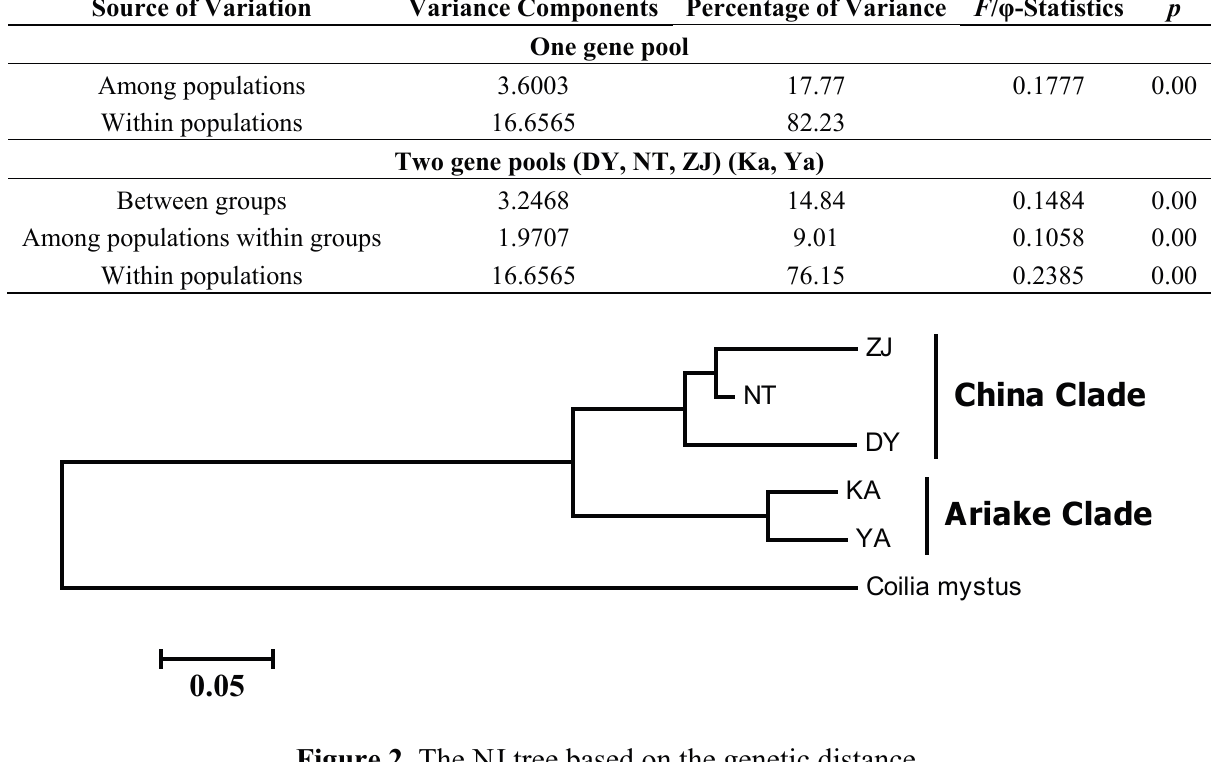
Figure 2. The NJ tree based on the genetic distance. Table 4. Genetic distance D (above) and pairwise F ST (below) between